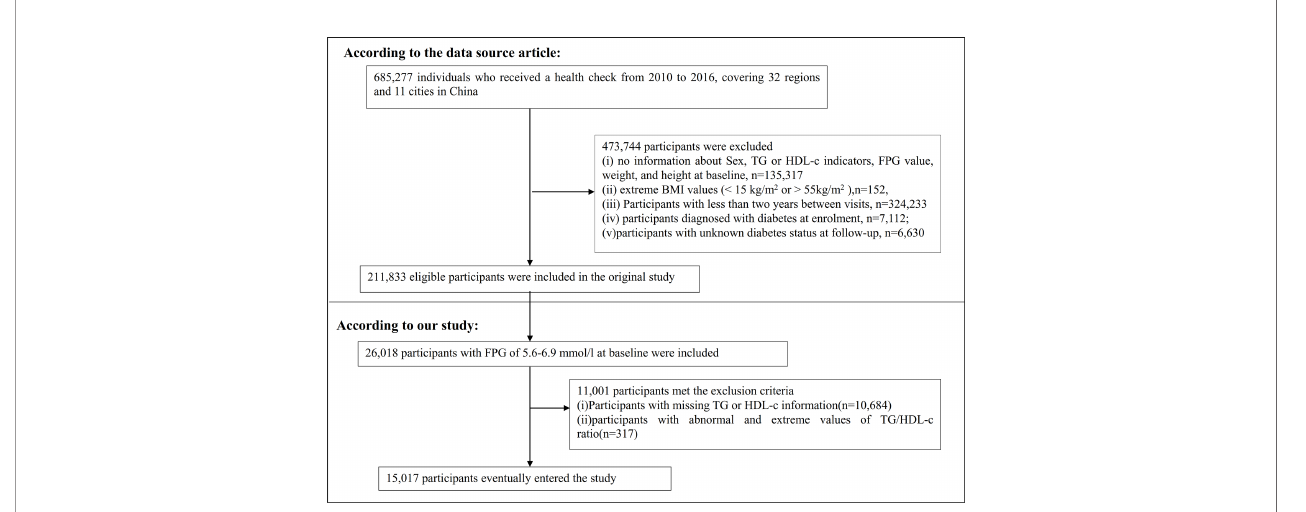
FIGURE 1 | Flowchart of study